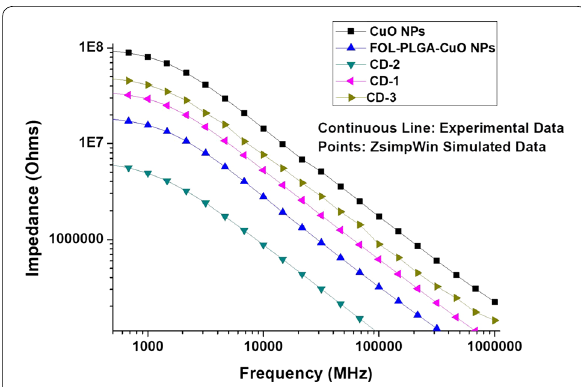
Fig. 9 Impedance values of CNE‑2 cells on treatment with CuO NPs, FOL‑PLGA‑CuO NPs, CD‑1, CD‑2 & CD‑3